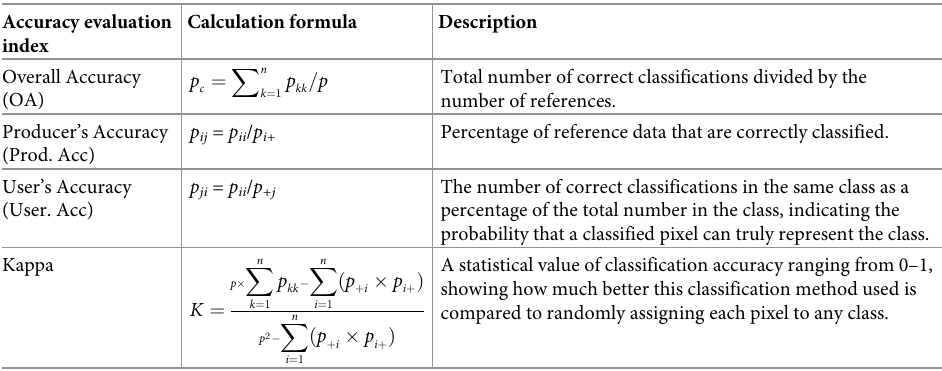
Table 2. Evaluation indicators for classification